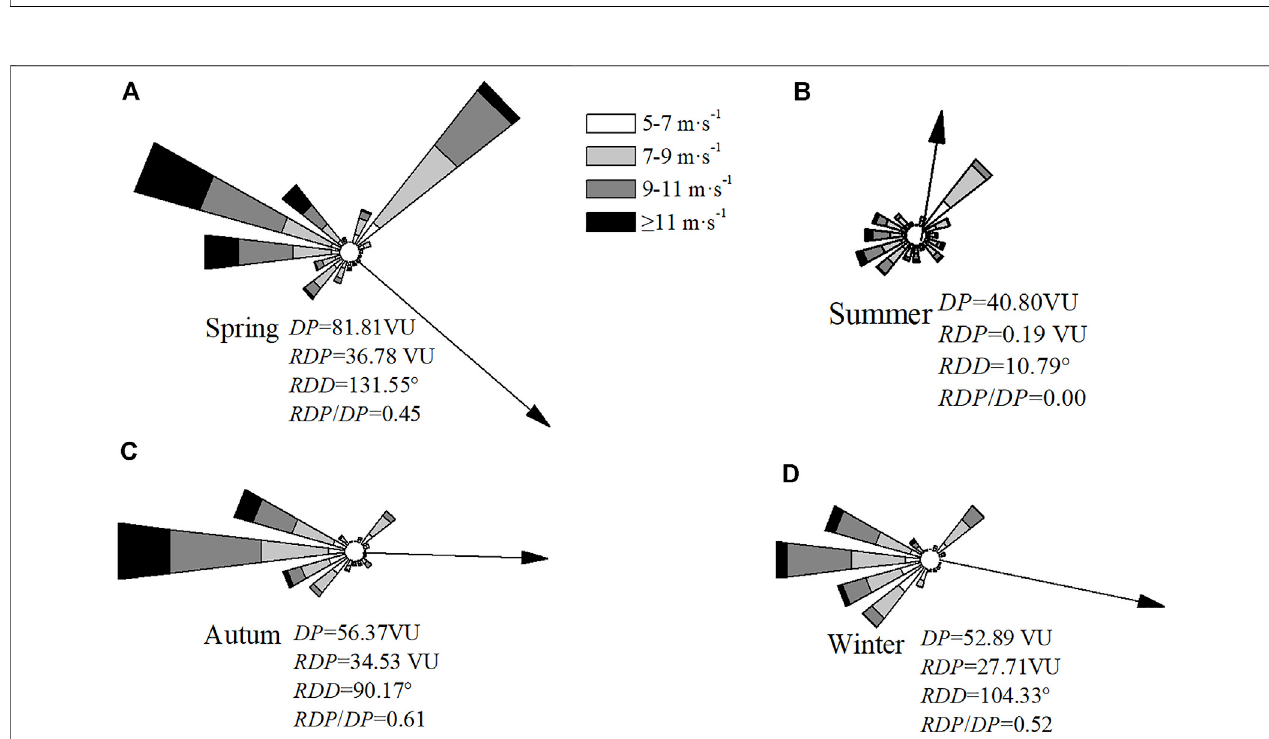
FIGURE 8 | Drift potential in the desert – oasis ecotone in (A) spring, (B) summer, (C) autumn, and (D) winter. The calculated resultant drift potential (RDP) and resultant drift direction (RDD) are shown in black arrow.